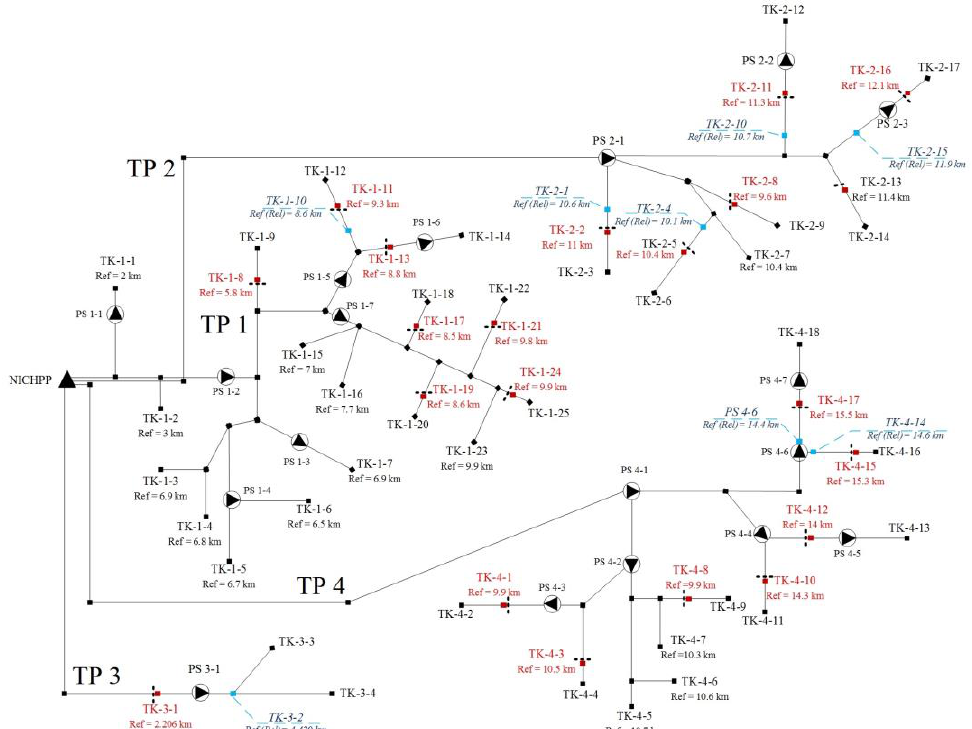
Fig. 2. Aggregate scheme of the DHS (NICHPP) with decisions on